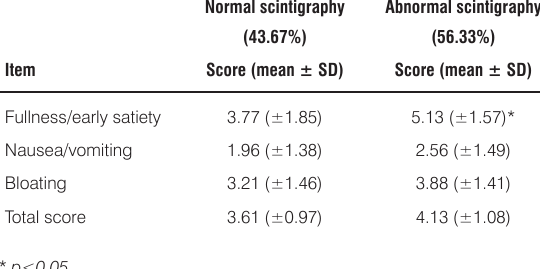
Table 3. GCSI according to scintigraphy (normal or delayed gastric